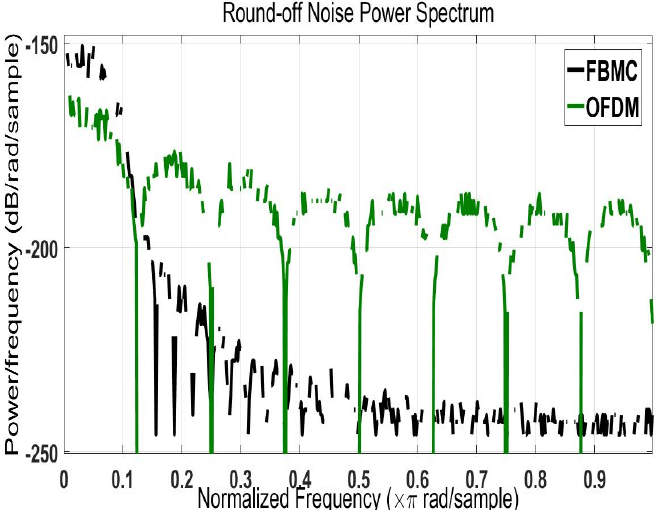
Figure 6. Noise PSD.